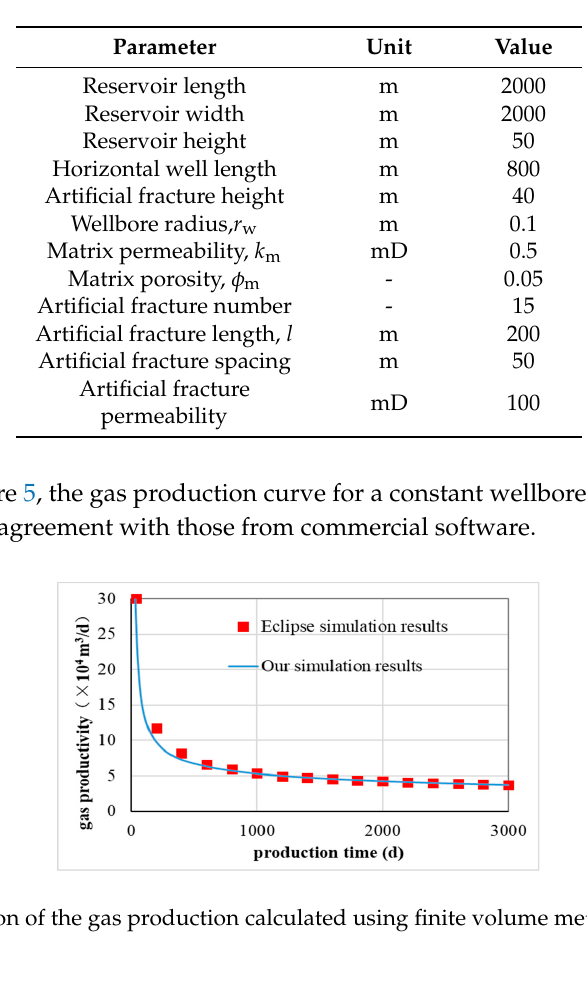
Table 2. Basic data of a multi-section fractured horizontal well in a single-porosity gas reservoir [27].